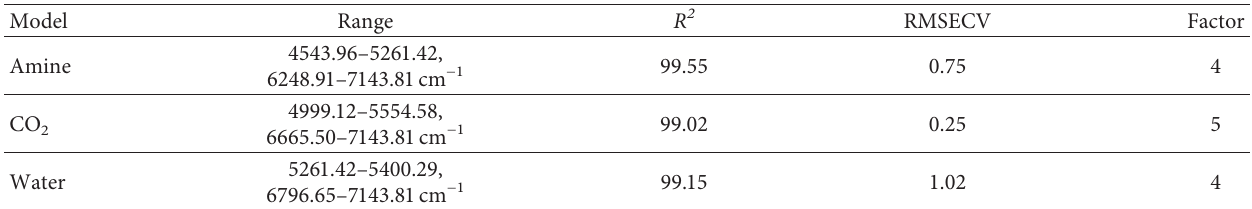
Table 2: Range, R 2 , RMSECV, and factor for different models of amine, CO